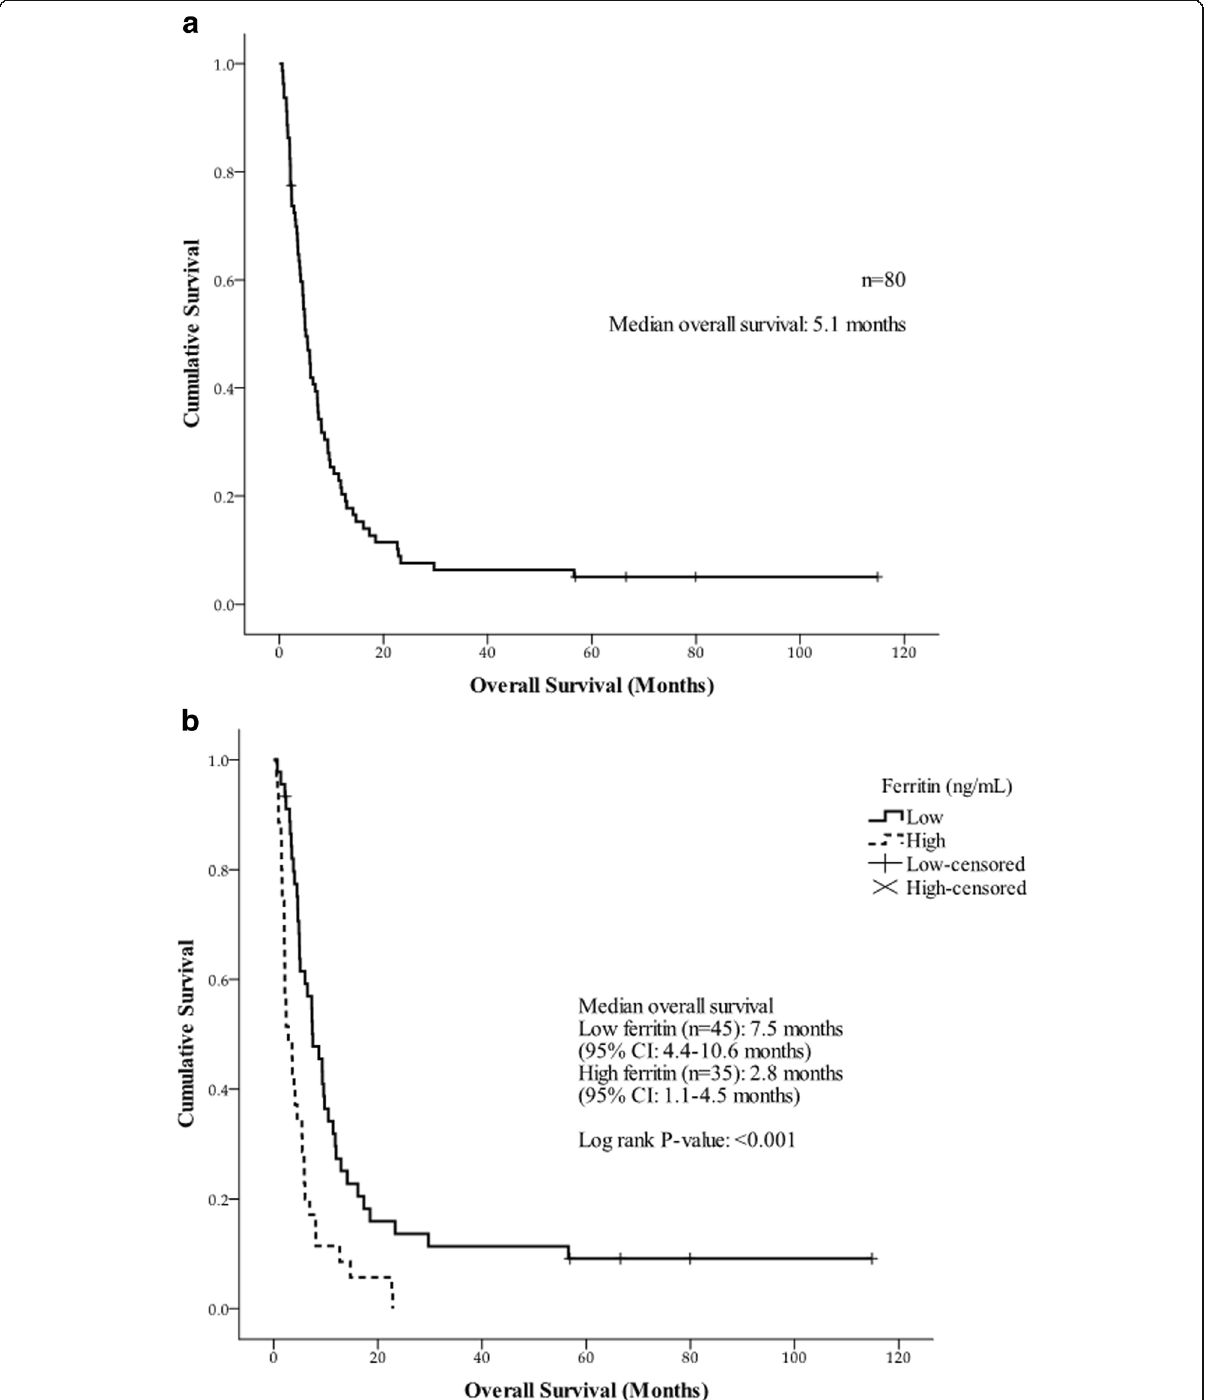
Fig. 2 Overall survival of enrolled patients. a Overall survival of all patients and b Overall survival according to serum ferritin level in advanced hepatobiliary